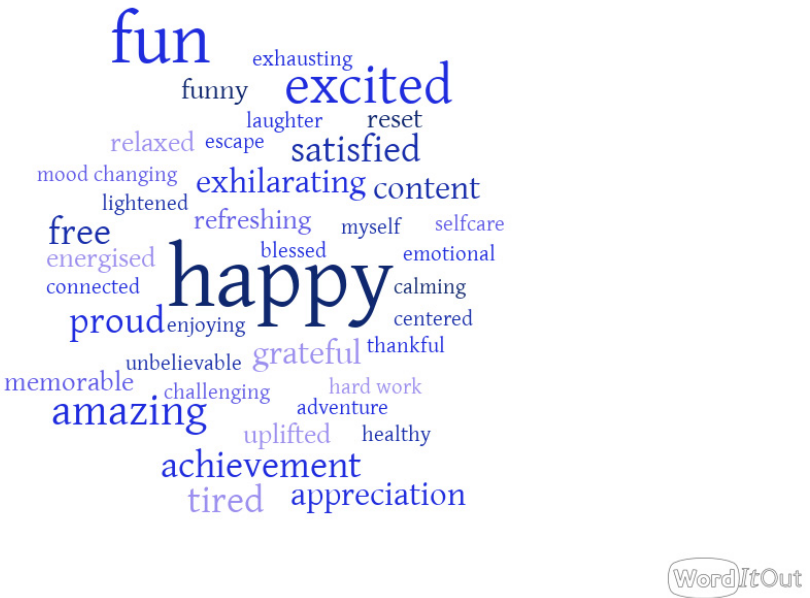
Figure 2. Word cloud for “What 3 words come to mind when thinking of your experience at The Wave?”.